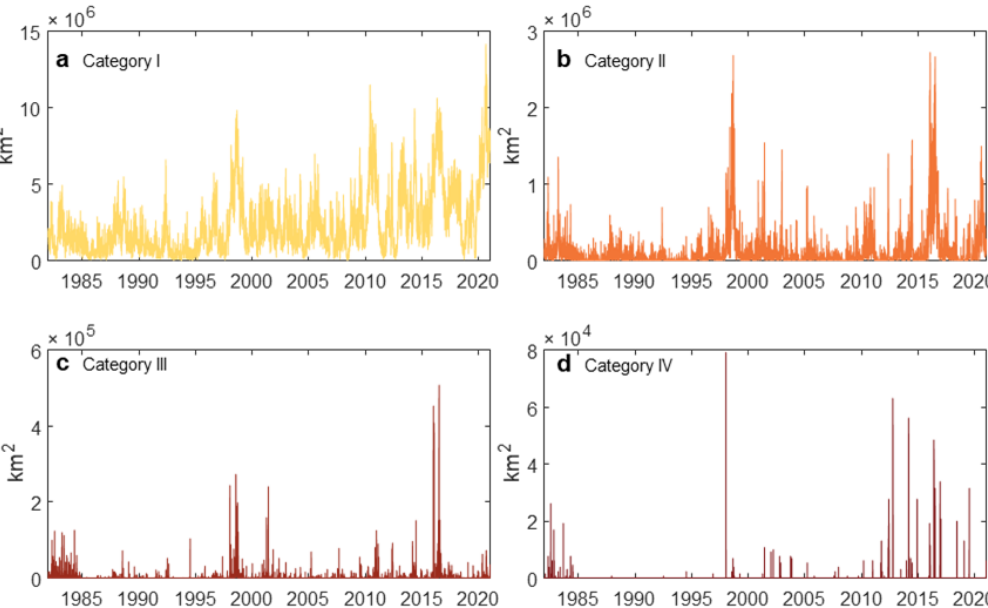
Figure 3. MHWs coverage in study area sorted by